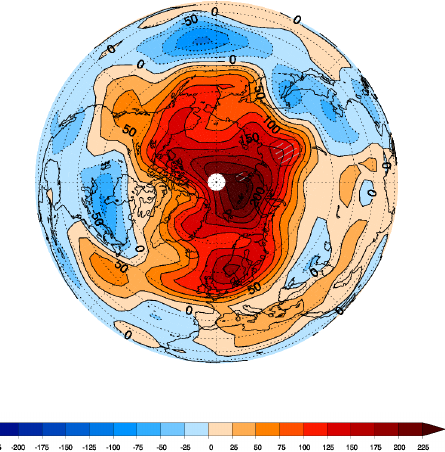
Fig. 8. Polar stereographic projection of changes in sea level pres- Fig. 8: Polar stereographic projection of changes in sea level pressure for the NH for day 211 475 to 311 resulting from the Carrington-like Event. Hatched areas show 95 % statistical signifi- 476 sure for the NH for day 211 to 311 resulting from the Carrington- like Event. Hatched areas show 95% statistical significance.